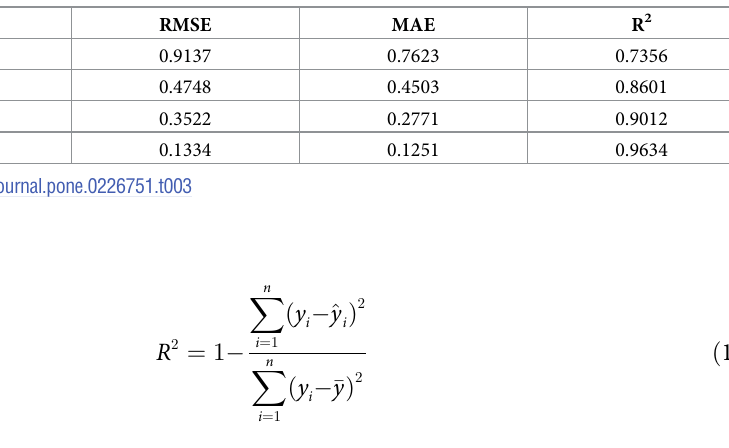
Table 3. Comparison of four algorithm prediction